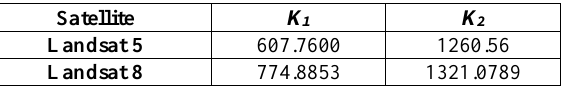
Table 4: NDVI for land use classes